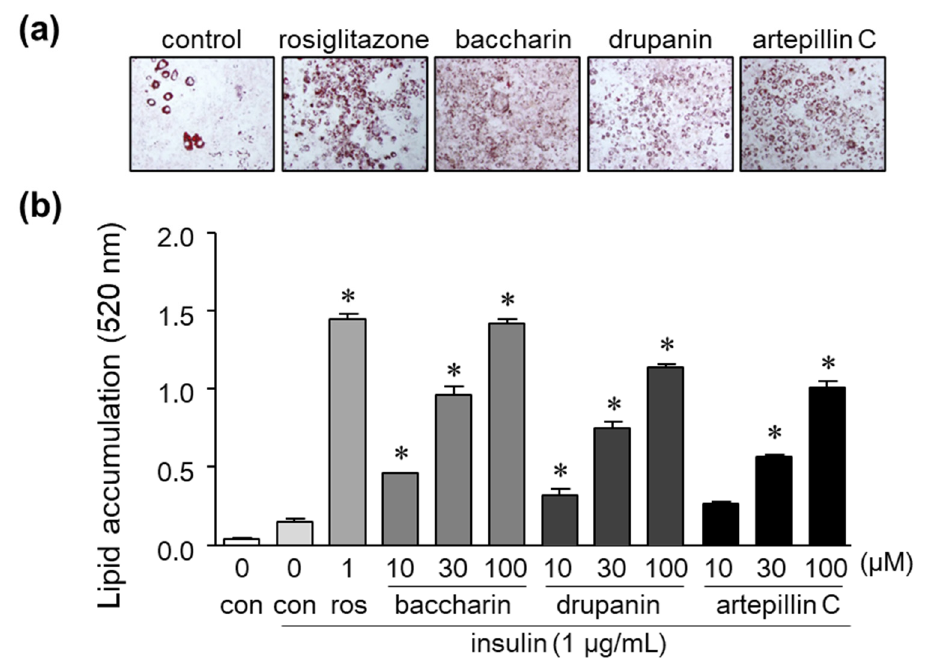
Figure 2. Effect of baccharin, drupanin, and artepillin C on lipid accumulation in 3T3-L1 cells. ( a ) 3T3-L1 preadipocytes were incubated in the presence of insulin (1 µg/mL) with rosiglitazone (1 µM), baccharin (30 µM), drupanin (30 µM), or artepillin C (30 µM) as described in the Methods section of this paper. The cells were then stained with Oil Red O and photographed. ( b ) The accumulated lipids stained with Oil Red O were dissolved, and the absorbance was measured using a spectrom- eter. Values are expressed as means ± SEM ( n = 3). * p < 0.05 compared with the control in the pres- ence of insulin. ros, rosiglitazone; con, control.